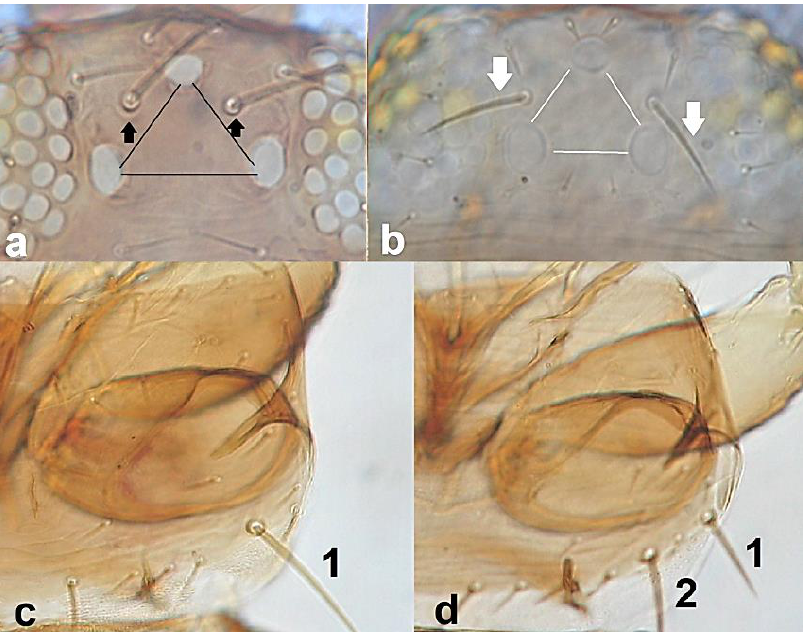
Figure 32. Clavus ( a,b ) : ( a ) with six marginal setae; ( b ) with five marginal setae. 34 Abdominal sternites bearing discal setae; ocellar setae iii arising just antero-lateral to ocellar triangle (Figure 33a); pronotum with one pair of postero-angular setae longer than discal setae (Figure 33c).......................................................... Oxythrips ajugae Uzel Abdominal sternites with no discal setae; ocellar setae iii either arising outside ocellar triangle (Figure 33b) or between hind ocelli; pronotum with two pairs of postero- angular setae longer than discal setae (Figure 33d) ........ Ceratothrips ericae (Haliday)